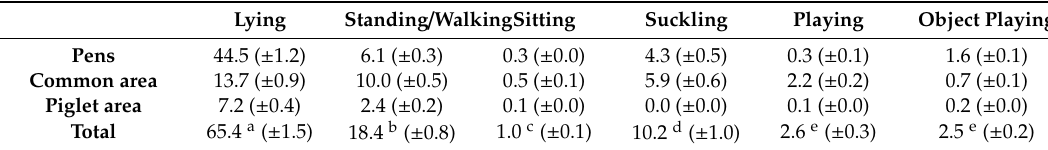
Table 3. Mean percentage and standard errors (±SE) of piglets showing various activities in the different locations. Significant differences are indicated by different letters ( p < 0.05).